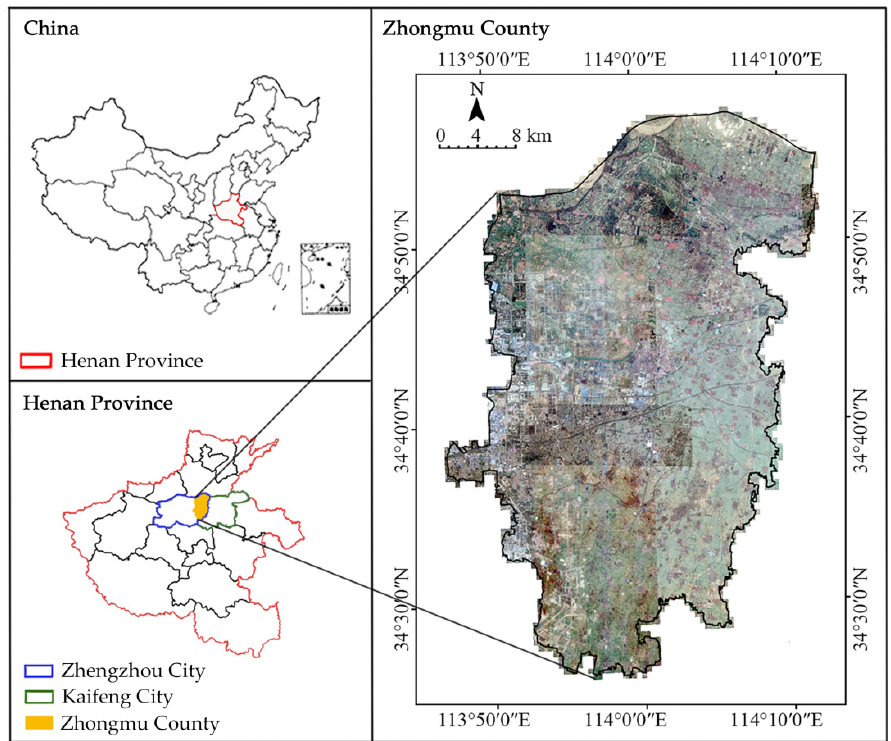
Figure 1. Location and satellite image of Zhongmu County.